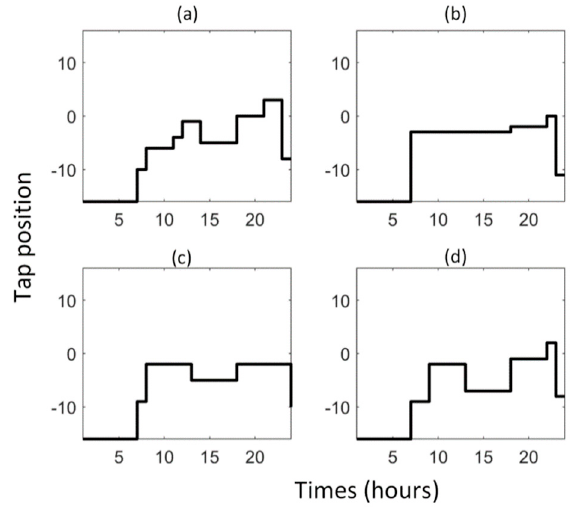
Figure 7. Tap position changes of one voltage regulator for case 1 ( a ), case 2 ( b ), case 3 ( c ) and case 4 ( d ).